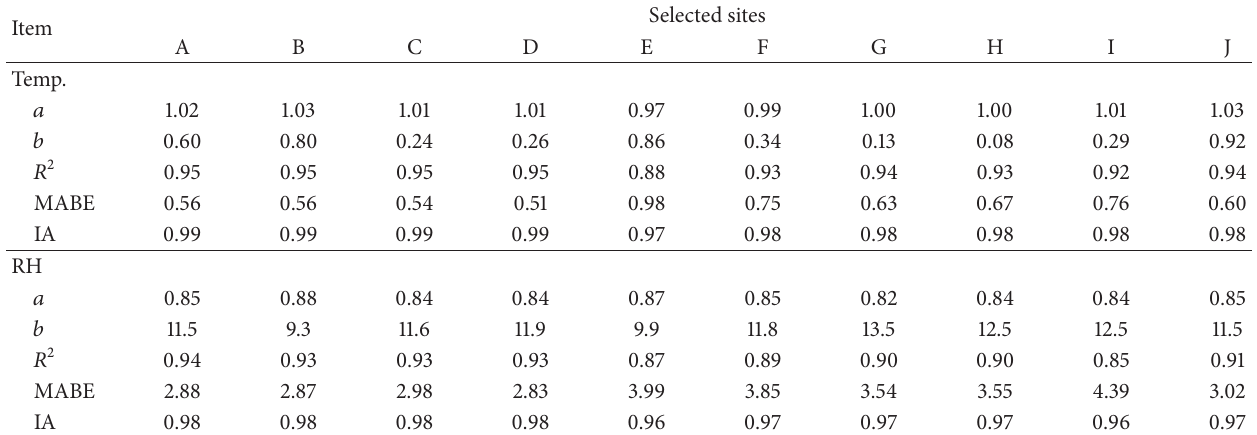
Table 4: The 𝑅 2 , MABE, and IA of 𝑦 = 𝑎𝑥 + 𝑏 for selected sites.